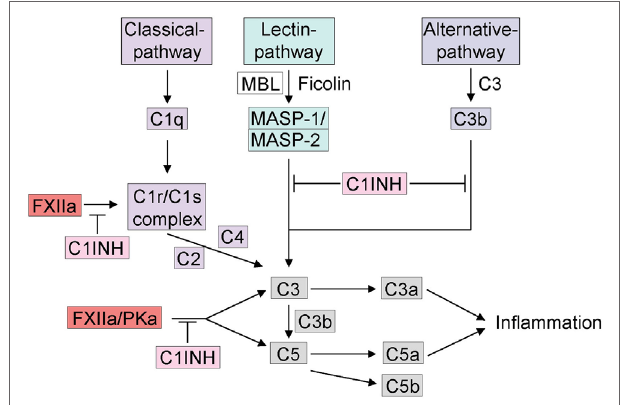
FiGURe 2 | Cross talk between the kallikrein–kinin system and the complement system. The complement system can be activated by three different pathways: (1) C1q initiates the activation of the classical pathway, (2) the mannose-binding lectin (MBL) or ficolins trigger the lectin pathway for glycosylation on the surface of pathogens. Activation of either the classical pathway or MBL generates C3 convertase. (3) If C3 is spontaneously hydrolyzed, the alternative pathway is activated and generates activated C3b. C3 and C5 release C3a and C5a, which can trigger inflammation. The activation of the complement system via the kallikrein–kinin system is indicated, mainly FXIIa and plasma kallikrein are involved in activation of C3 and C5. FXIIa can trigger the C1r/C1s complex. C1INH inhibits the complement system in all three different pathways and furthermore via the inhibition of the kallikrein–kinin